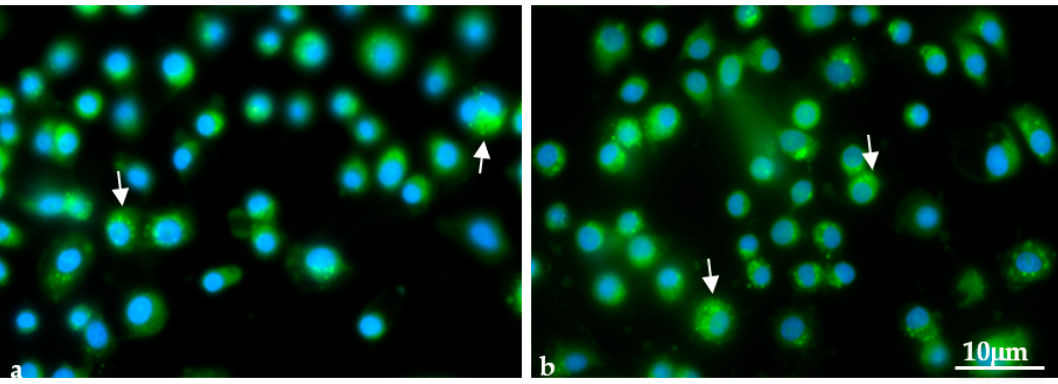
Figure 5. Morphological alterations of SKBR3 cells after treatment with 5 ( a ) and 10 ( b ) µ g/mL of Vepris macrophylla EO at 48 h. Arrowheads indicate probably vesicles filled with